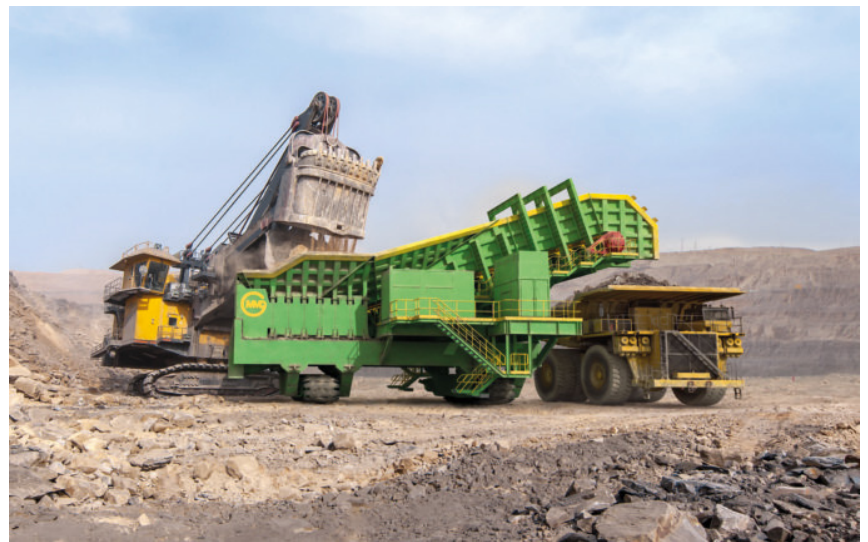
Figure 2. New Shovel-Truck system.